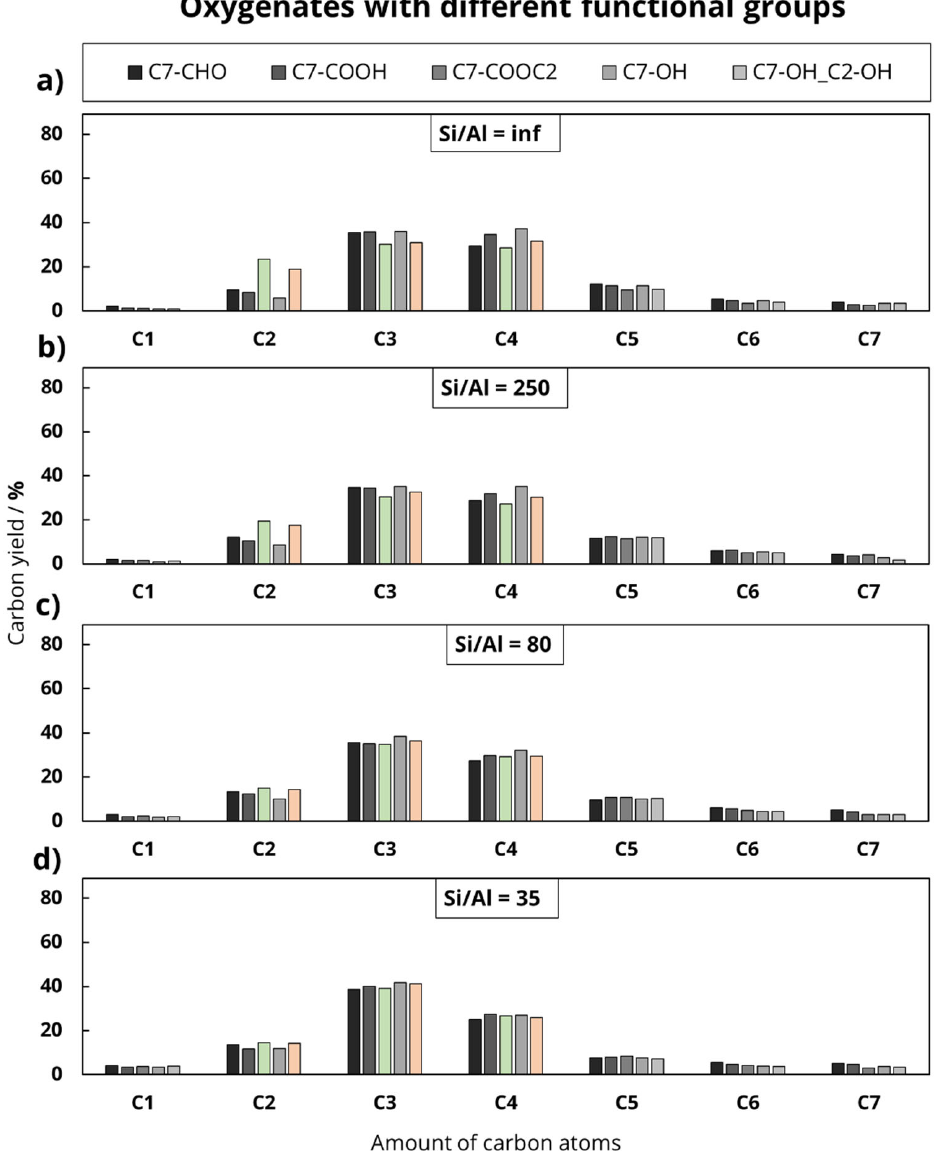
Figure 6. Comparison of catalytic results of prepared H-ZSM-5 zeolite samples with various Si/Al ratios ( a – d ) in the conversion of oxygenates with different functional groups; green and orange bars : relatively increased carbon yield for C2 products and decreased carbon yield for C3 and C4 products for feeds containing a C2 chain (C7-COOC2 = ethyloctanoate, C7-OH_C2-OH = equimolar solution of 1 ‐ heptanol and ethanol).